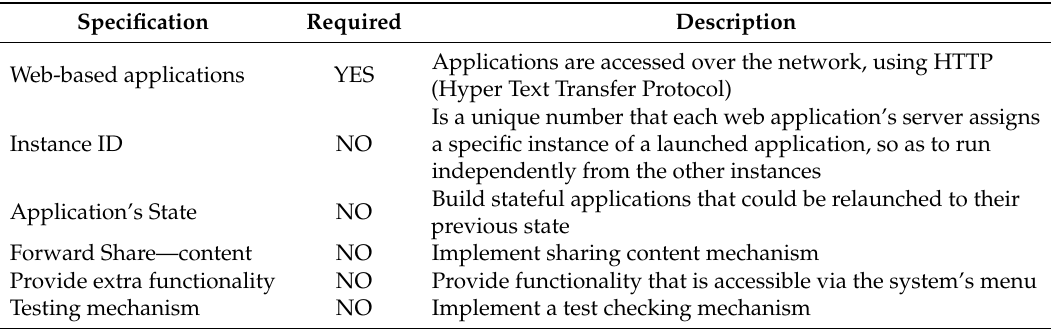
Table 5. Specifications that external applications should satisfy to be successfully integrated. Specification Required Description Applications are accessed over the network, using HTTP Web-based applications YES (Hyper Text Transfer Protocol) Instance ID a specific instance of a launched application, so as to run independently from the other instances Application’s State previous